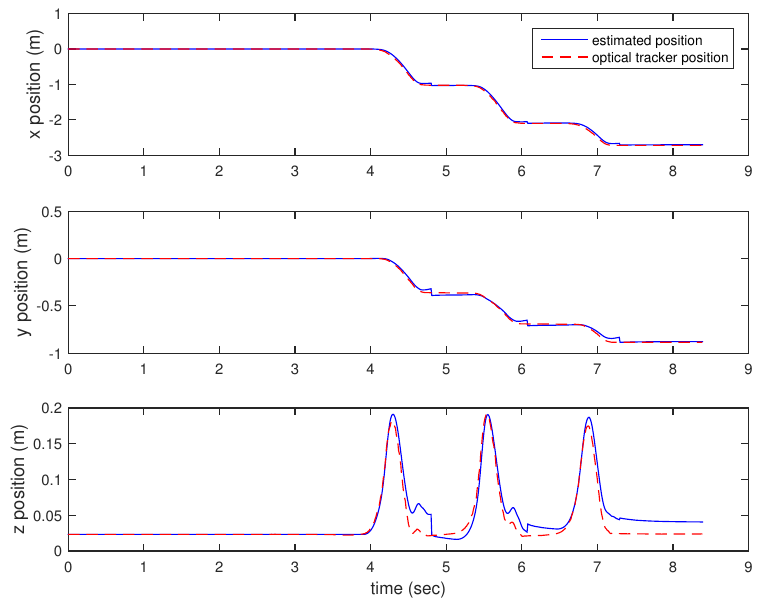
Figure 4. Walking position estimation: K.F. (zero velocity updating). K.F., Kalman